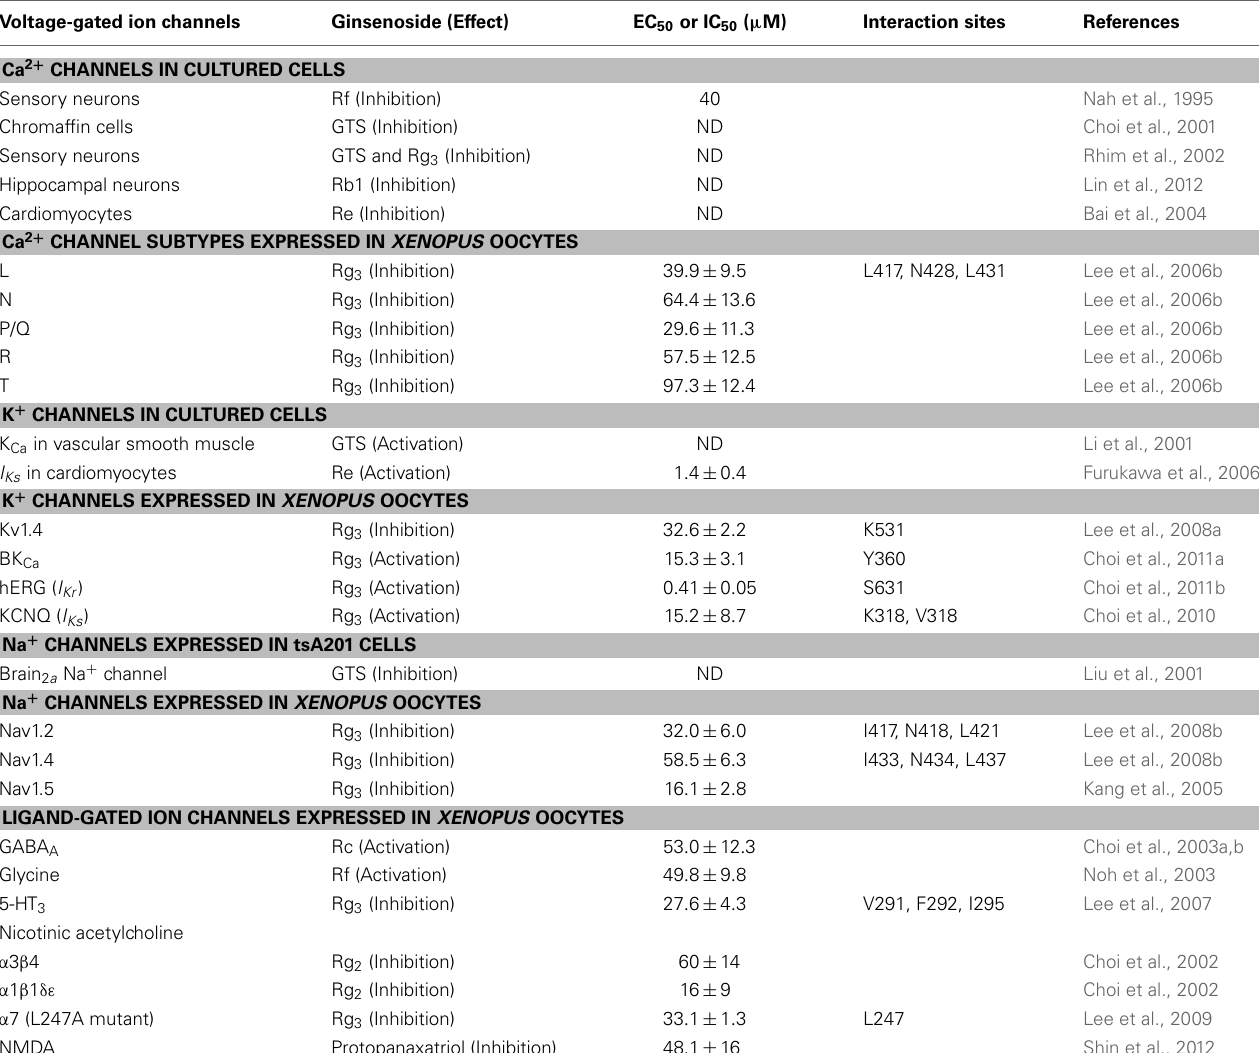
Table 1 | Summary of EC 50 or IC 50 on ginsenoside-induced inhibition or stimulation of various voltage-gated ion or ligand-gated ion channel